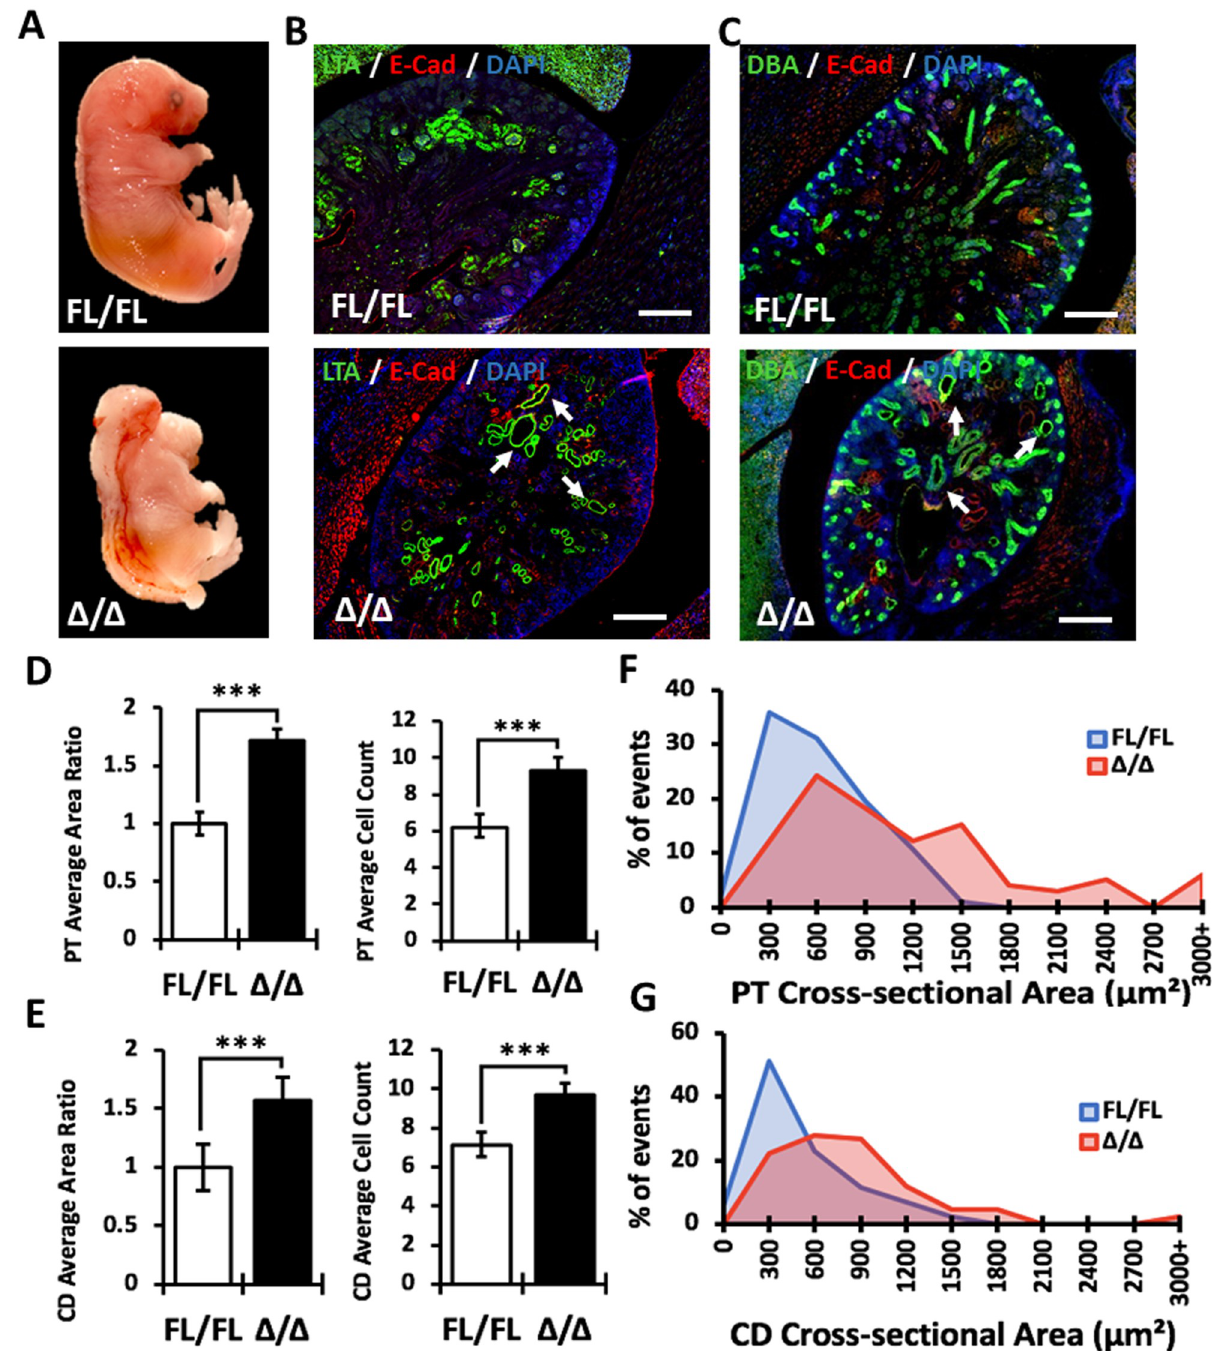
Fig 3. Analysis of kidney morphology in null E17.5 Vangl2 Δ / Δ embryos. (A) E17.5 Vangl2 Fl/Fl (upper image) and null Vangl2 Δ / Δ (lower image) embryos. (B) Immunofluorescence staining of E17.5 Vangl2 Fl/Fl and Vangl2 Δ / Δ kidney sections with LTA (green), E-cadherin (marker for lateral cell connections, red) and DAPI (blue); cystic and dilated proximal tubules are indicated by arrows. Scale bars, 100 μ m. (C) Immunofluorescence staining of E17.5 Vangl2 Fl/Fl and Vangl2 Δ / Δ kidney sections with DBA (green), E-cadherin (red) and DAPI (blue); cystic and dilated collecting ducts indicated by arrows. Scale bars, 100 μ m. (D) Measurements of proximal tubule (PT) area ratio and cell count: Vangl2 Fl/Fl (n = 80), Vangl2 Δ / Δ (n = 77). (D) Measurements of collecting duct (CD) area ratio and cell count: Vangl2 Fl/Fl (n = 88), Vangl2 Δ / Δ (n = 86). (E) Percentage of events within a given range of tubular cross-sectional area of proximal tubules. (F). Percentage of events within a given range of tubular cross-sectional area of collecting duct tubules. Mean ± standard error of mean is shown in all graphs. p < 0.05 ( � ), p < 0.001 ( �� ), p < 0.0001 ( ��� ).